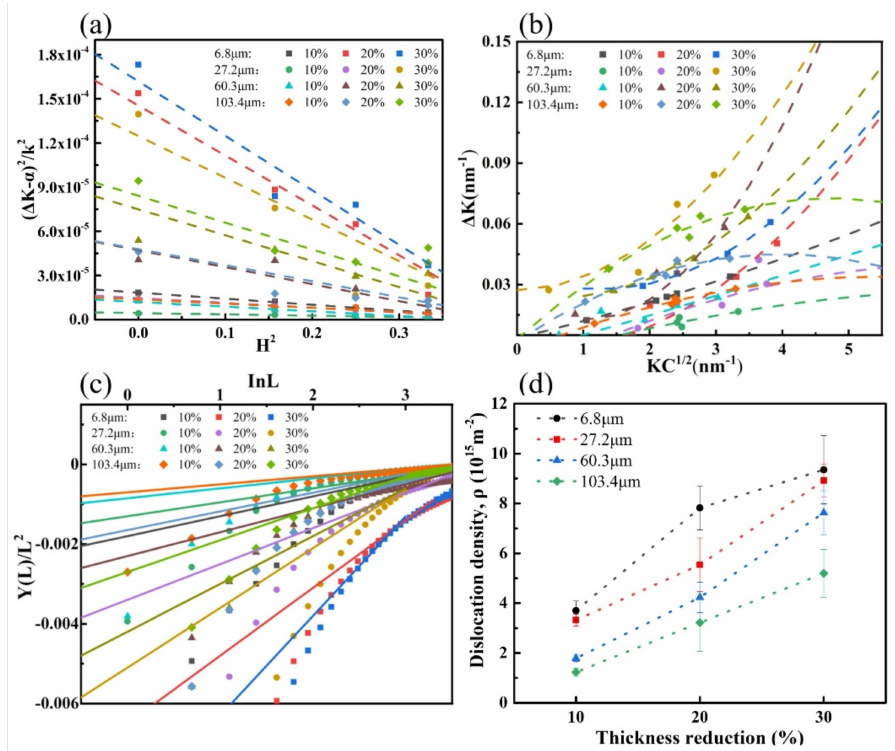
Figure 10. The relationship patterns of the experimental steels with different grain size under different reduction on mWH/WA method: ( a ) ( ∆ K − α ) 2 / K 2 and H 2 ; ( b ) KC 1/2 and ∆ K ; ( c ) Y ( L ) / L 2 and lnL . And ( d ) is the calculated dislocation density of each